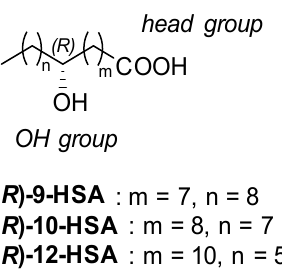
Figure 1. Structures of ( R )-9-hydroxystearic acid (HSA), ( R )-10-has, and ( R )-12-HSA, hydroxystearic acids (HSA) with the OH group at positions 9, 10, and 12, respectively.